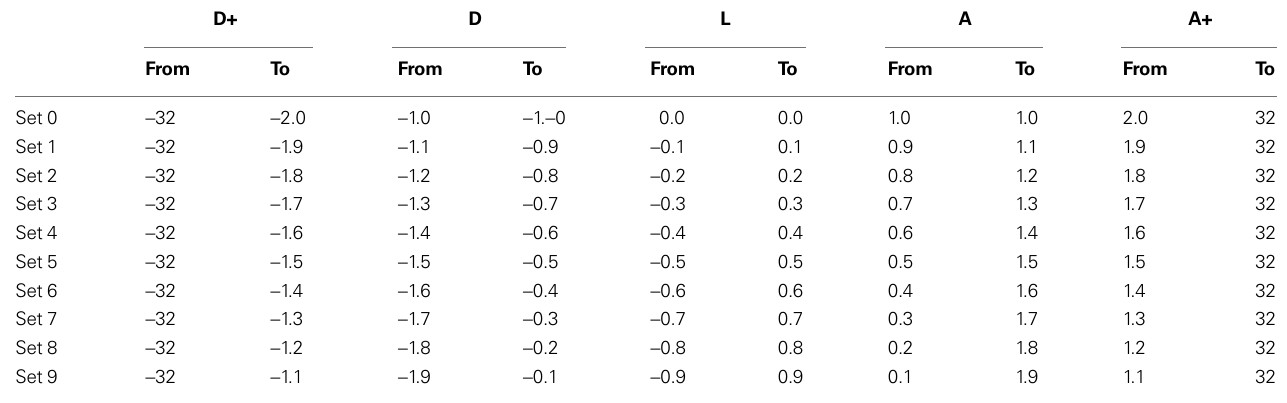
Table 1 | The borders of the ranges for the different constraint sets. D+ D L A A+ From To From To From To From To From